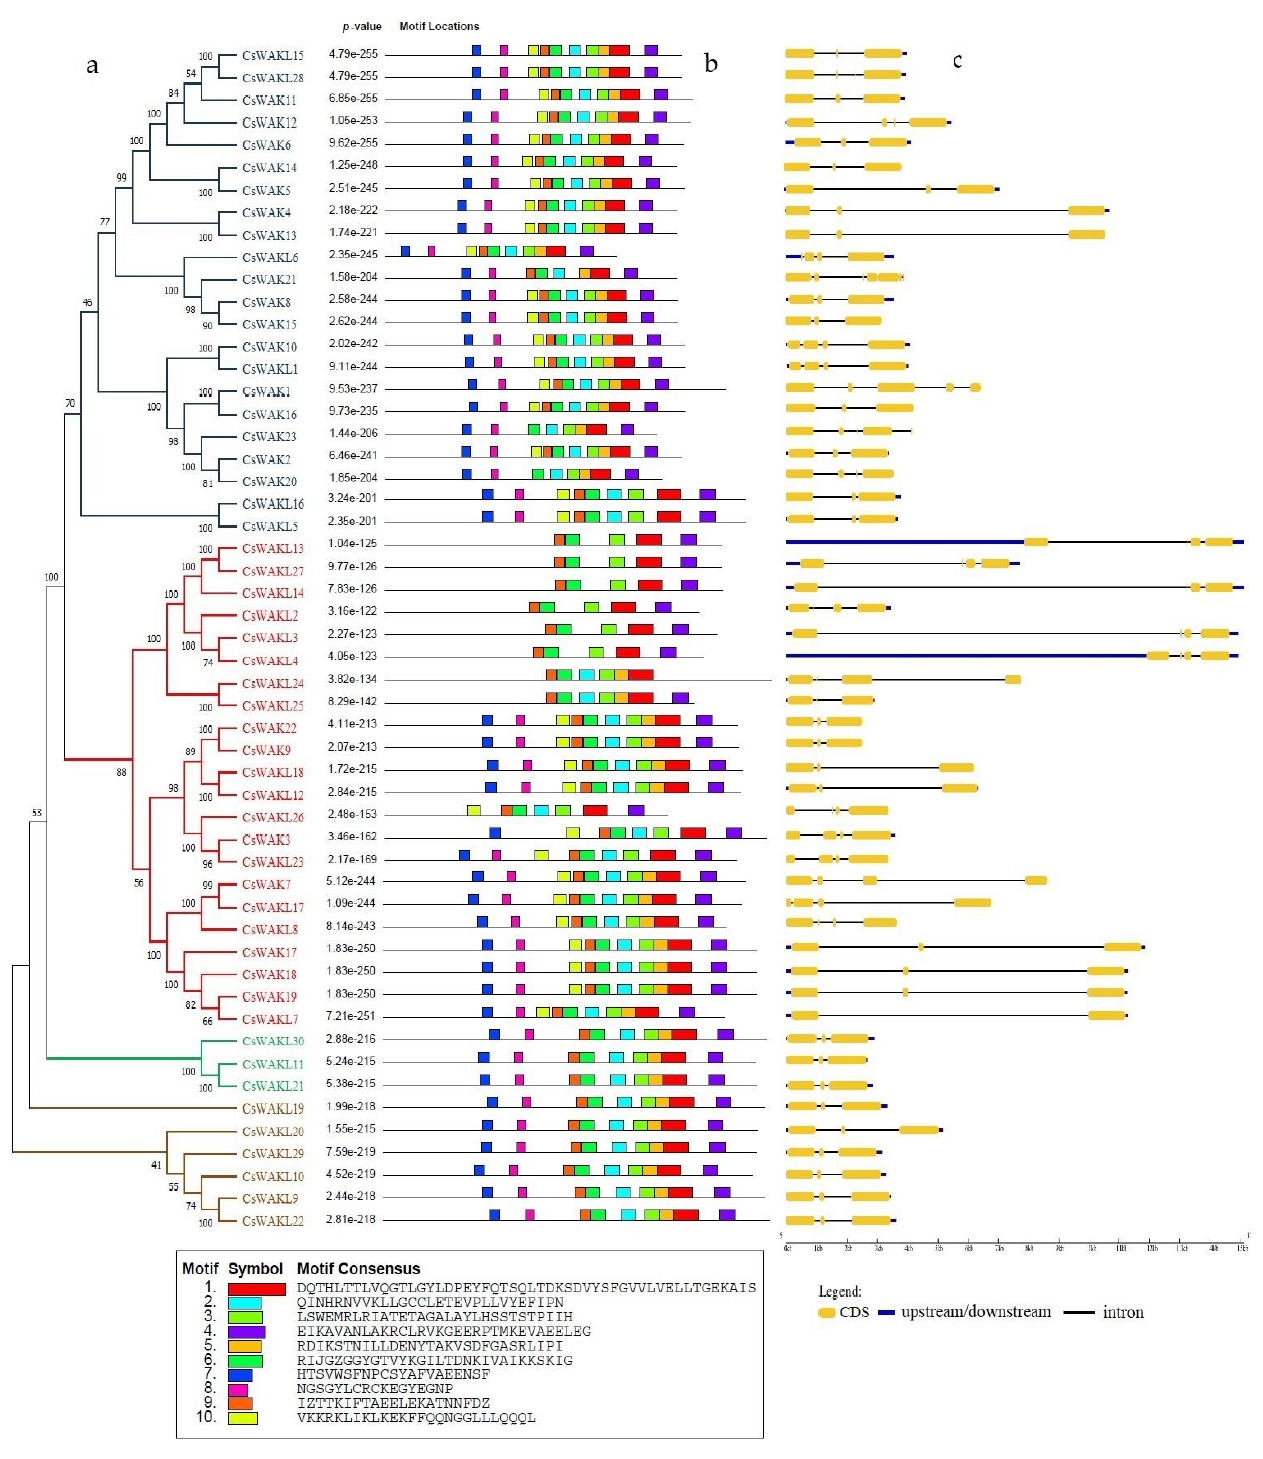
Figure 6. The phylogenetic tree of CsWAK/CsWAKL proteins in Cannabis sativa constructed with 1000 bootstrap using the neighbor-joining algorithm ( a ) and the motif sites of the CsWAK/CsWAKL protein sequences ( b ). The height of the block gives the indication of the significance of the site, where taller blocks are more significant. ( c ) Gene structure of CsWAK s/ CsWAKLs . The yellow boxes, blue lines, and black lines represent the CDS regions, upstream/downstream regions, and the introns, respectively.